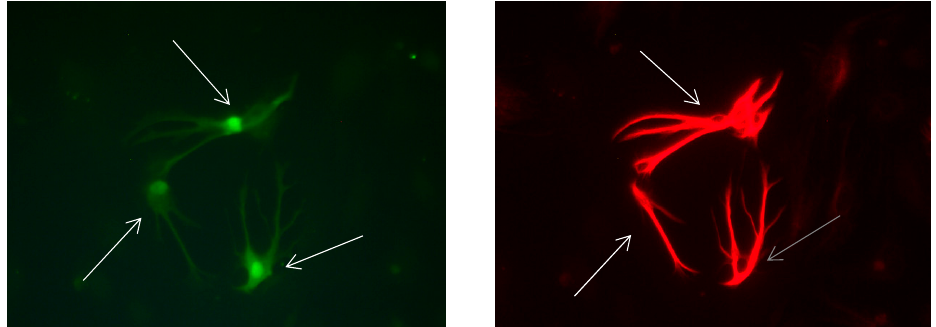
Figure 11. Cultures in a serum-free medium, 5 days (6 days after the passage): Immunofluorescence with anti-GFAP (glial fibrillary acidic protein) (red, secondary antibody: donkey anti-goat IgG Alexa Fluor 594), and with anti-Calbindin D28k (polyclonal antibody from the company SWANT) (green, secondary antibody: donkey anti-rabbit IgG Alexa Fluor 488). Epifluorescence microscopy. Three Calbindin D28k positive and GFAP-positive astrocytes (long arrows) with processes.